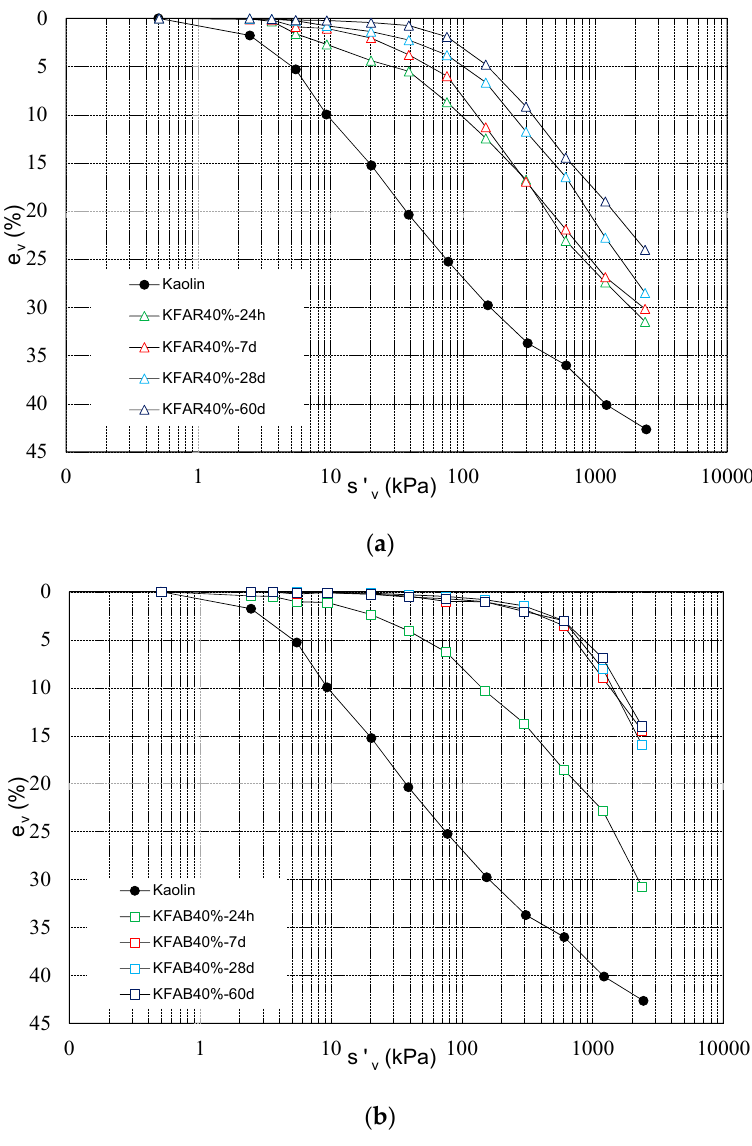
Figure 3. One dimensional compression tests on not treated and treated kaolin as function of curing time: ( a ) KFAR40%; ( b ) KFAB40%.